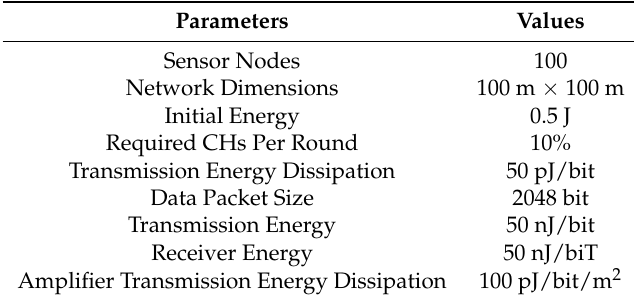
Table 1. Characterization of simulation parameters.